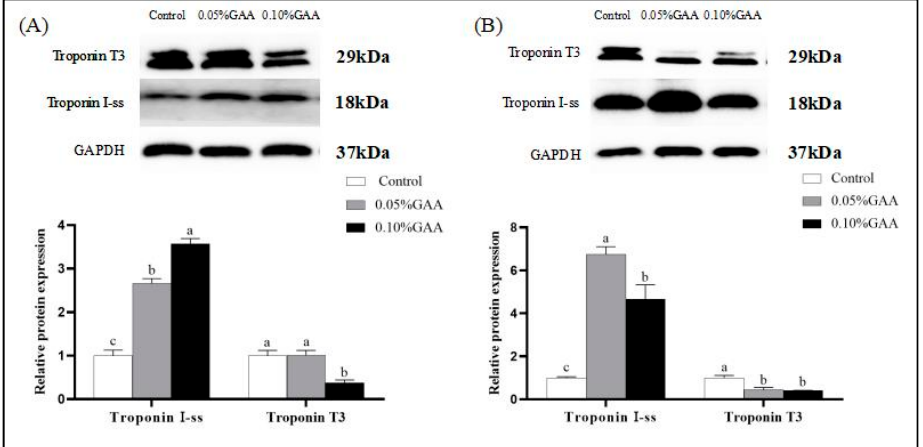
Figure 1. Effects of guanidinoacetic acid supplementation on the protein expressions of Troponin I - ss, Troponin T3 of ( A ) longissimus thoracis muscle, and ( B ) semitendinosus muscle in finishing pigs. Means with different letters differ significantly ( p < 0.05). Values are presented as the mean ± SEM ( n = 5). Control: Finishing pigs were fed a basal diet; 0.05% GAA or 0.10% GAA: Finishing pigs were fed a basal diet supplemented with GAA at 500 or GAA at 1000 mg kg − 1 ; Troponin I -ss: Troponin I slow type; Troponin T3: Troponin Ⅱ b fast skeletal type; GAPDH: Glyceraldehyde-3-phosphate dehydrogenase.